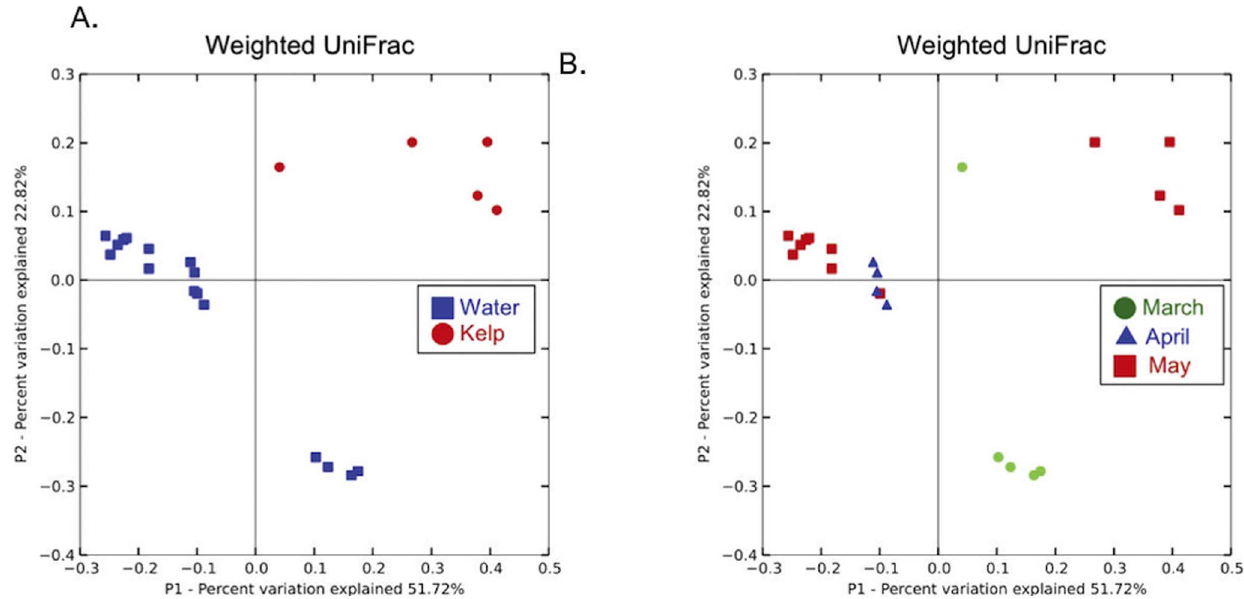
Figure 4. Weighed UniFrac principal coordinates analysis (PCoA) computed at exactly 510 sequences/sample illustrate the influence of sample type (Fig. 4A) and sample collection date (Fig. 4B). The coloring reflects the different dates on which the samples were taken (green = March, blue = April, red = May). ‘‘Kelp’’ refers to the kelp surface samples; ‘‘Water’’ refers to the seawater samples adjacent to the kelp sampled as well as those sampled outside the perimeter of the kelp forest. Percentages of variance explained by each principal coordinate (P1 and P2) are shown on the x- and y-axes.